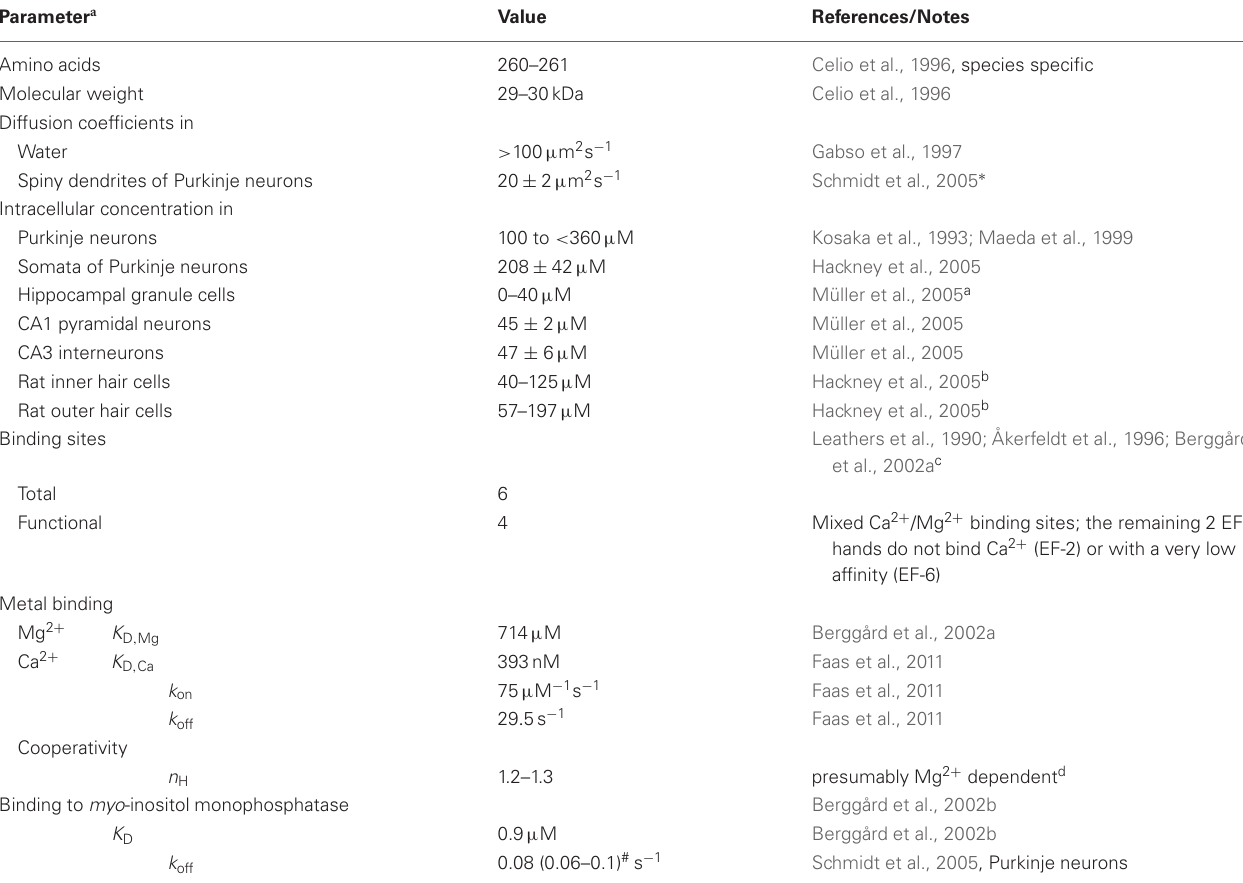
Table 1 | Properties of calbindin